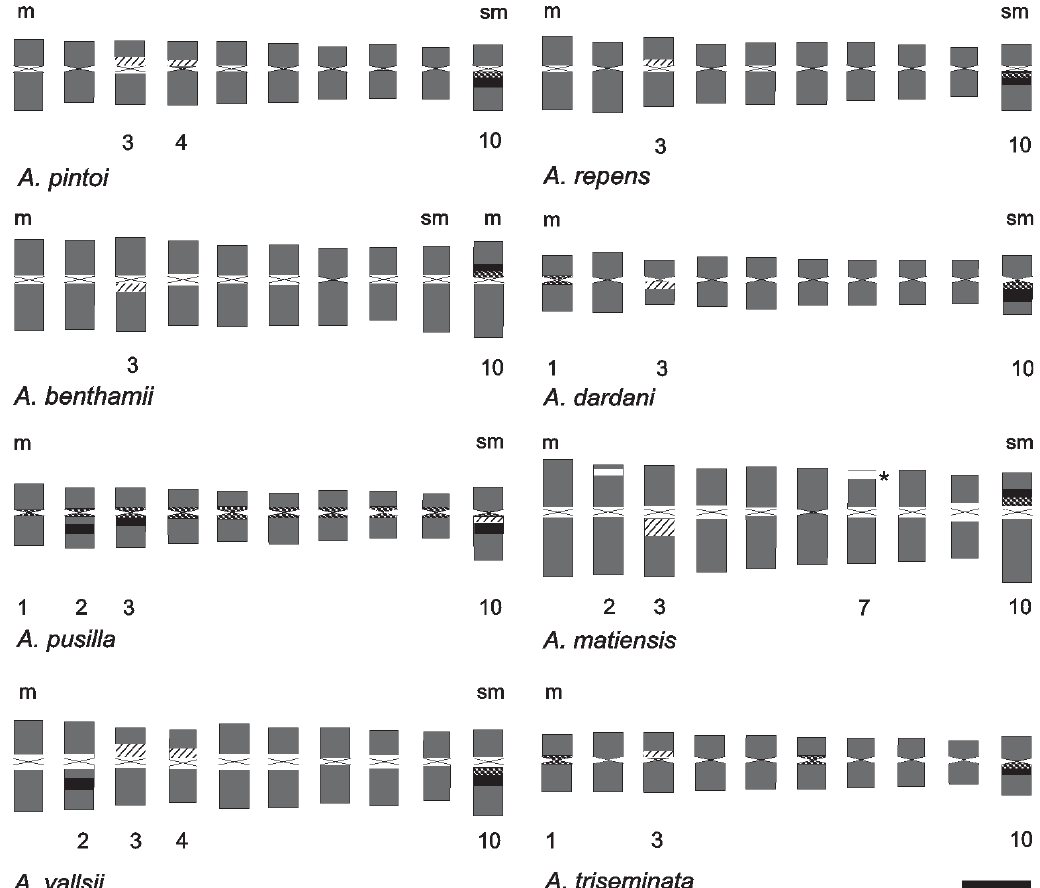
Figure 2. Idiograms of Arachis species, showing the distribution of 5S (striped) and 18S-26S rDNA loci (black shaded), DAPI heterochromatic bands (white shaded), and CMA heterochromatic bands (point bands). The chromosomes are ordered by morphology according to decreasing size, but some chromosomes were re- arranged according to tentative homologies between the karyotypes. *band observed in only one homologous chromosome. m= metacentric, sm= submetacentric. Scale bar 2